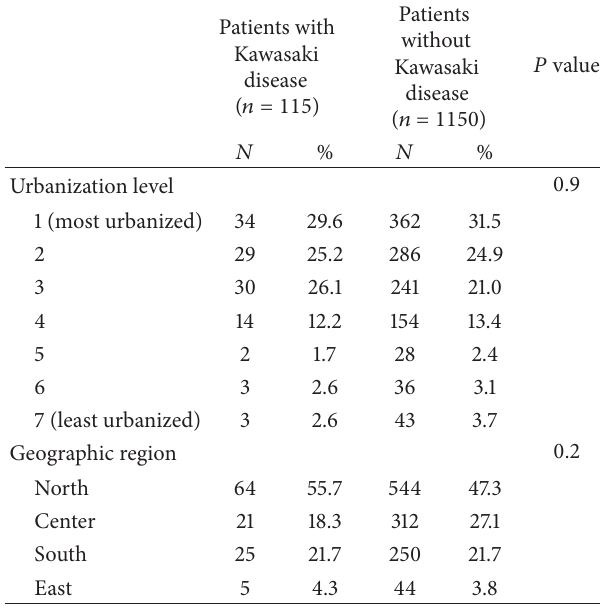
Table1:DemographiccharacteristicsforselectedKDpatients,strat- Table 2: Association between urbanization level and Kawasaki dis-